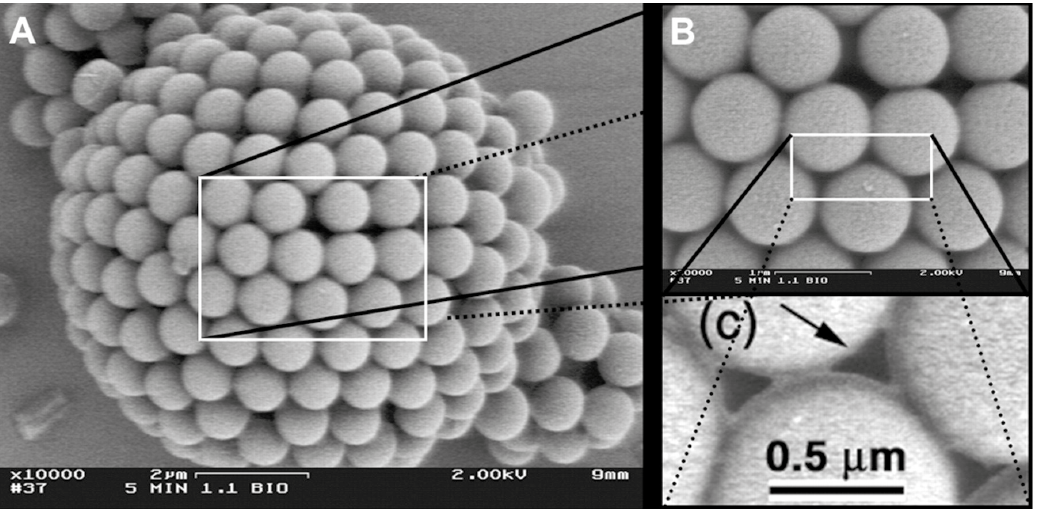
Figure 16. SEM image of 10 µ m-diameter colloidosome composed of 0.9 µ m-diameter polystyrene spheres. The colloidosome was formed with an oil droplet containing 50 vol% vegetable oil and 50 vol% toluene, and a water phase containing 50 vol% glycerol ( A ). The close-ups show the 0.15- µ m holes that define the permeability ( B , C ). Figure reproduced from Ref.